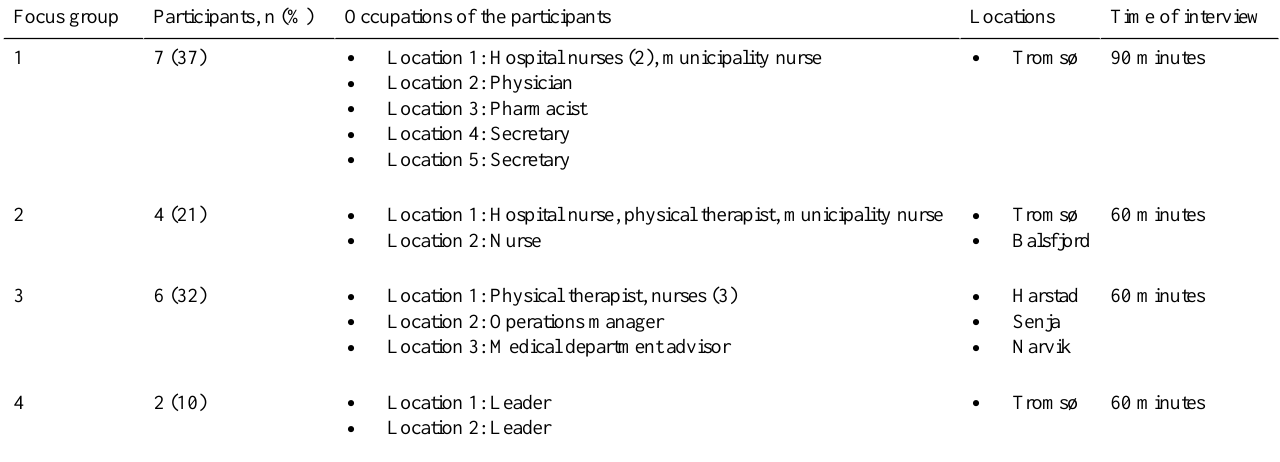
Table 1. Overview of the focus group interview participants